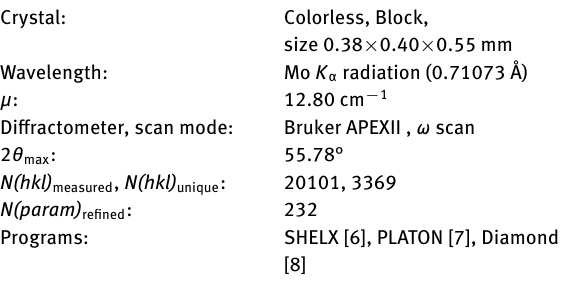
Table 2: Fractional atomic coordinates and isotropic or